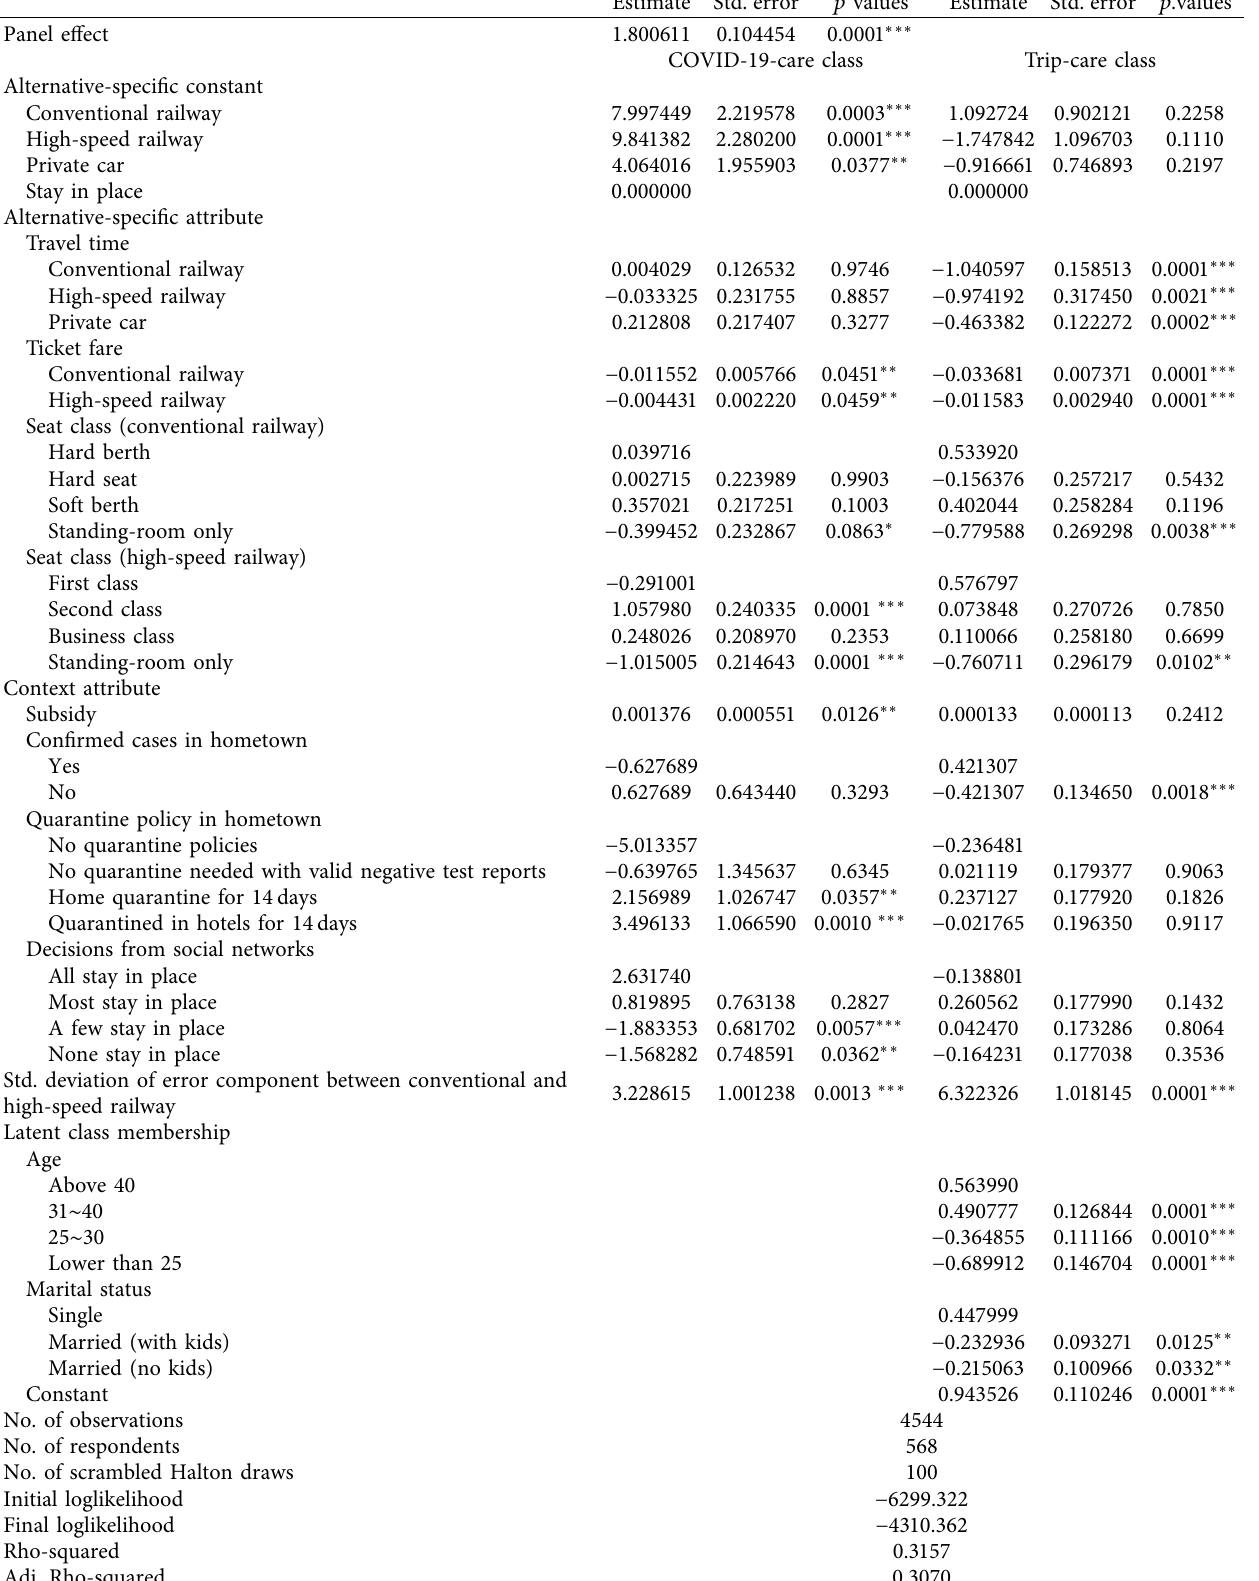
Table 3: Estimation results of the fnal